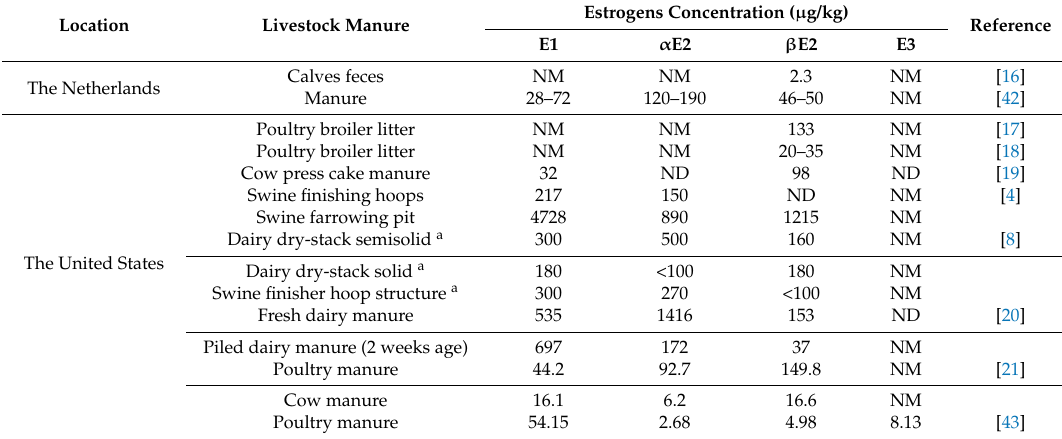
Table 3. Documented concentrations of estrogens in livestock